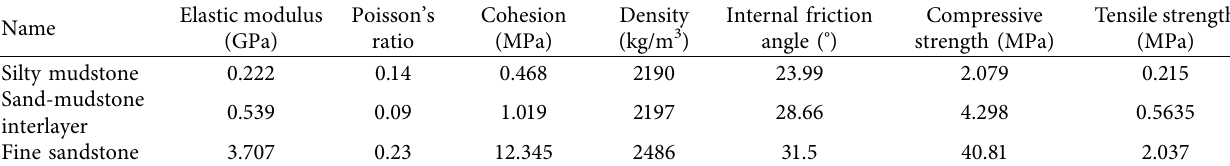
Table 6: Physical and mechanical parameters of rock mass after